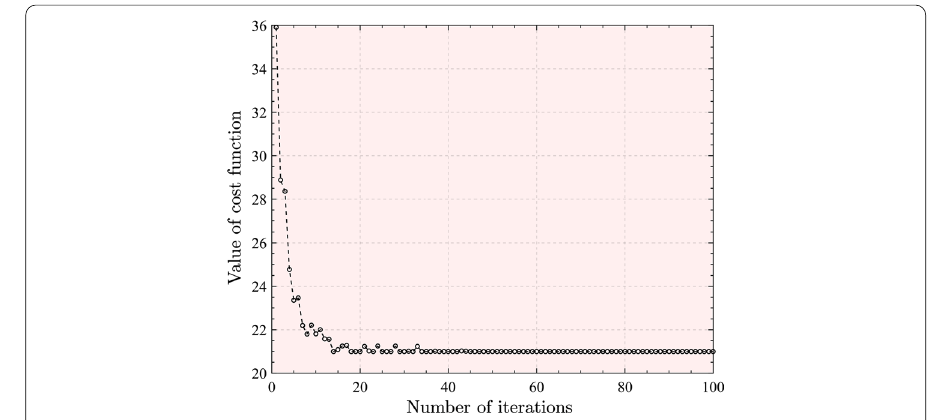
Fig. 13 Algorithm iteration curve at signal-to-noise ratio of